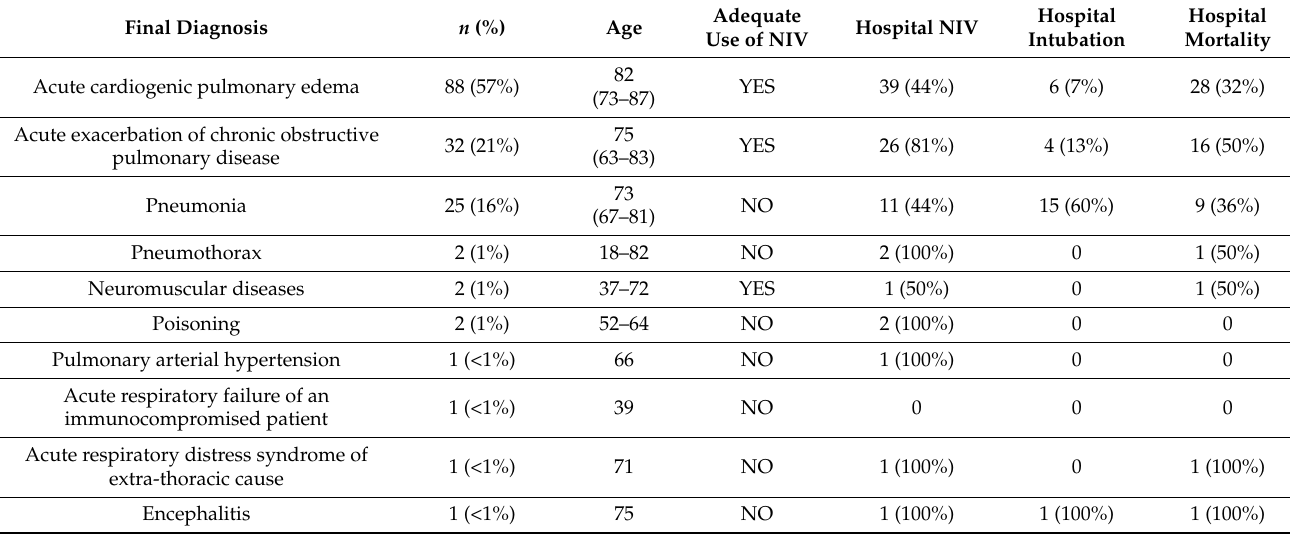
Table 2. Hospital outcomes of the 155 patients with prehospital noninvasive ventilation and the available hospital data. Final Diagnosis n (%) Age